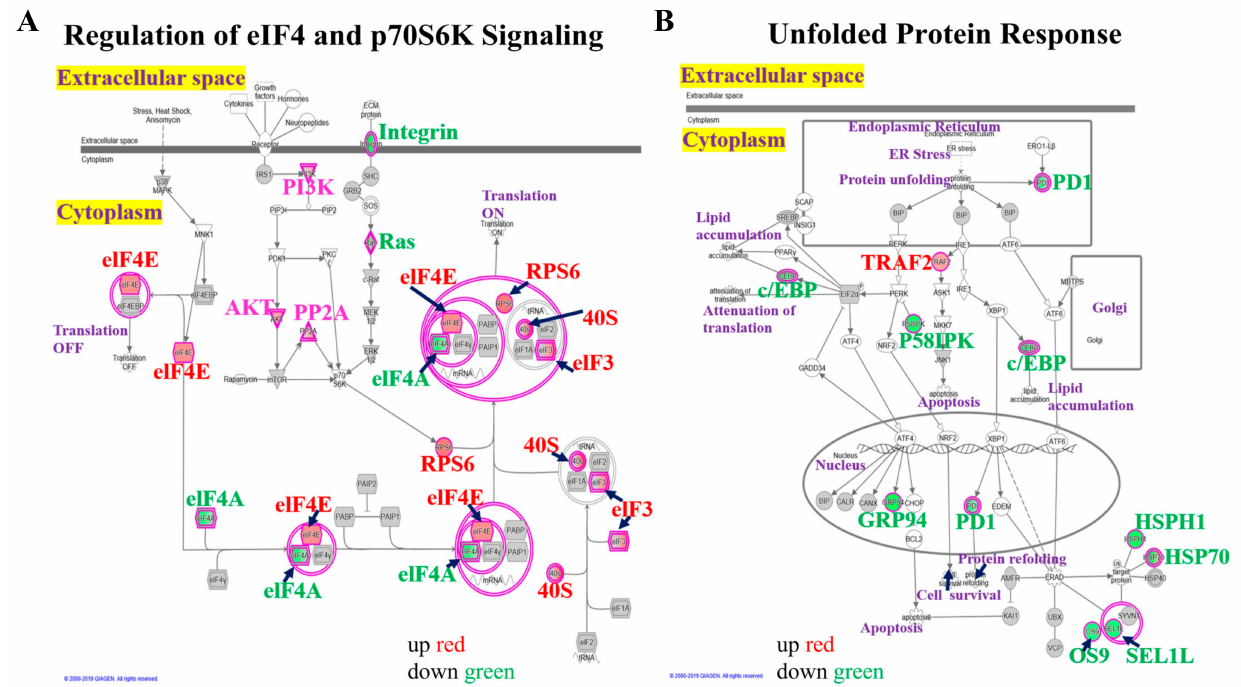
Figure 4. Enrichment of eIF4/p70S6K and unfolded protein response pathways in the KO cells. Canonical pathway analysis revealed the ( A ), regulation of eIF4 and p70S6K signaling pathway and ( B ), the UPR pathway among the topmost canonical pathways enriched upon mdig knockout. Nodes represent molecules in a pathway, whereas the biological relationship between nodes is represented by a line (edge). Edges are supported by at least one reference in the Ingenuity Knowledge Base. The intensity of color in a node indicates the degree of up (red) or down (green)